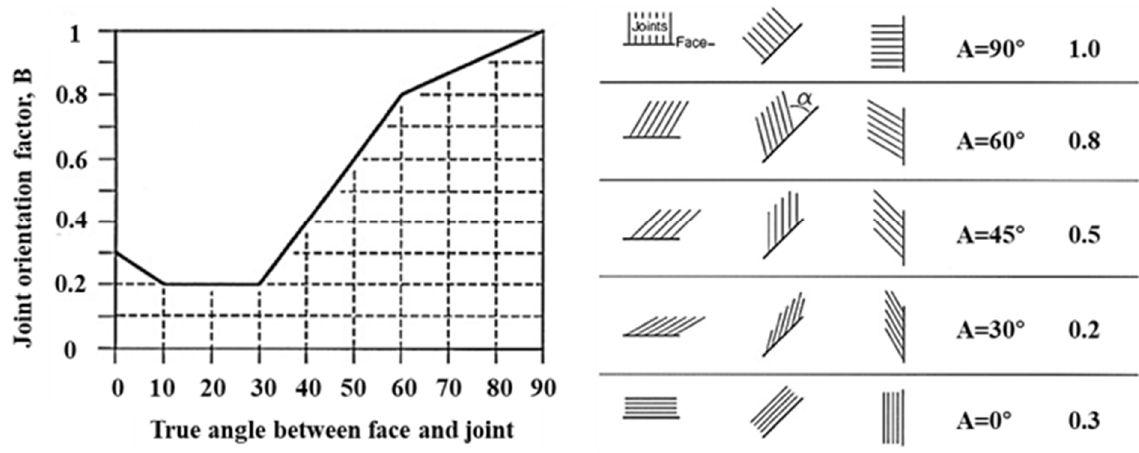
Figure 12. Joint occurrence adjustment coefficient.